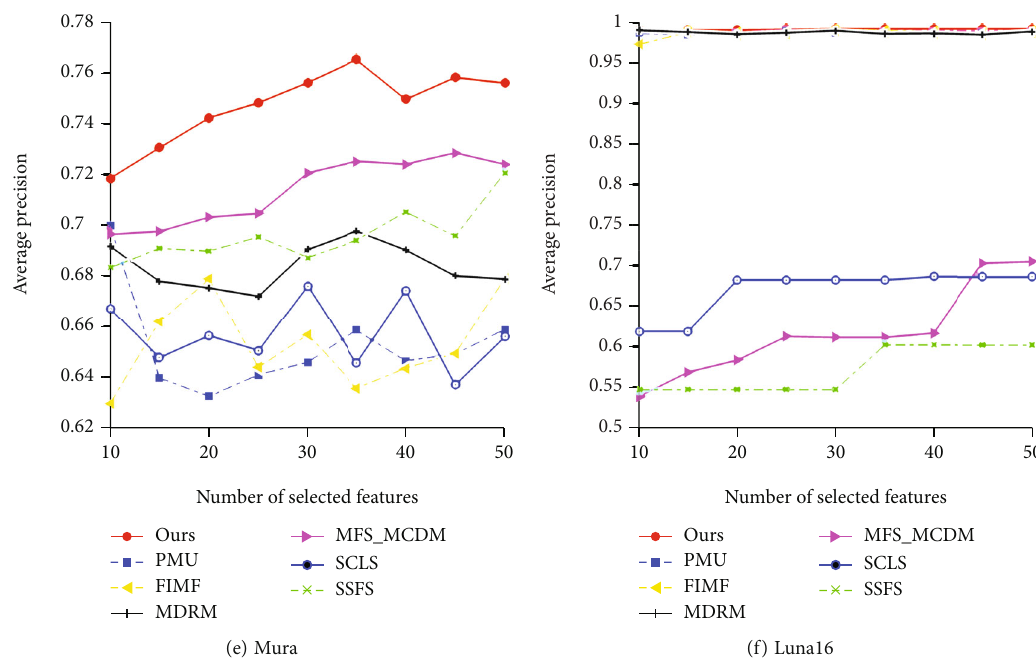
Figure 6: Average precision: the quality of each algorithm varies with the selected feature